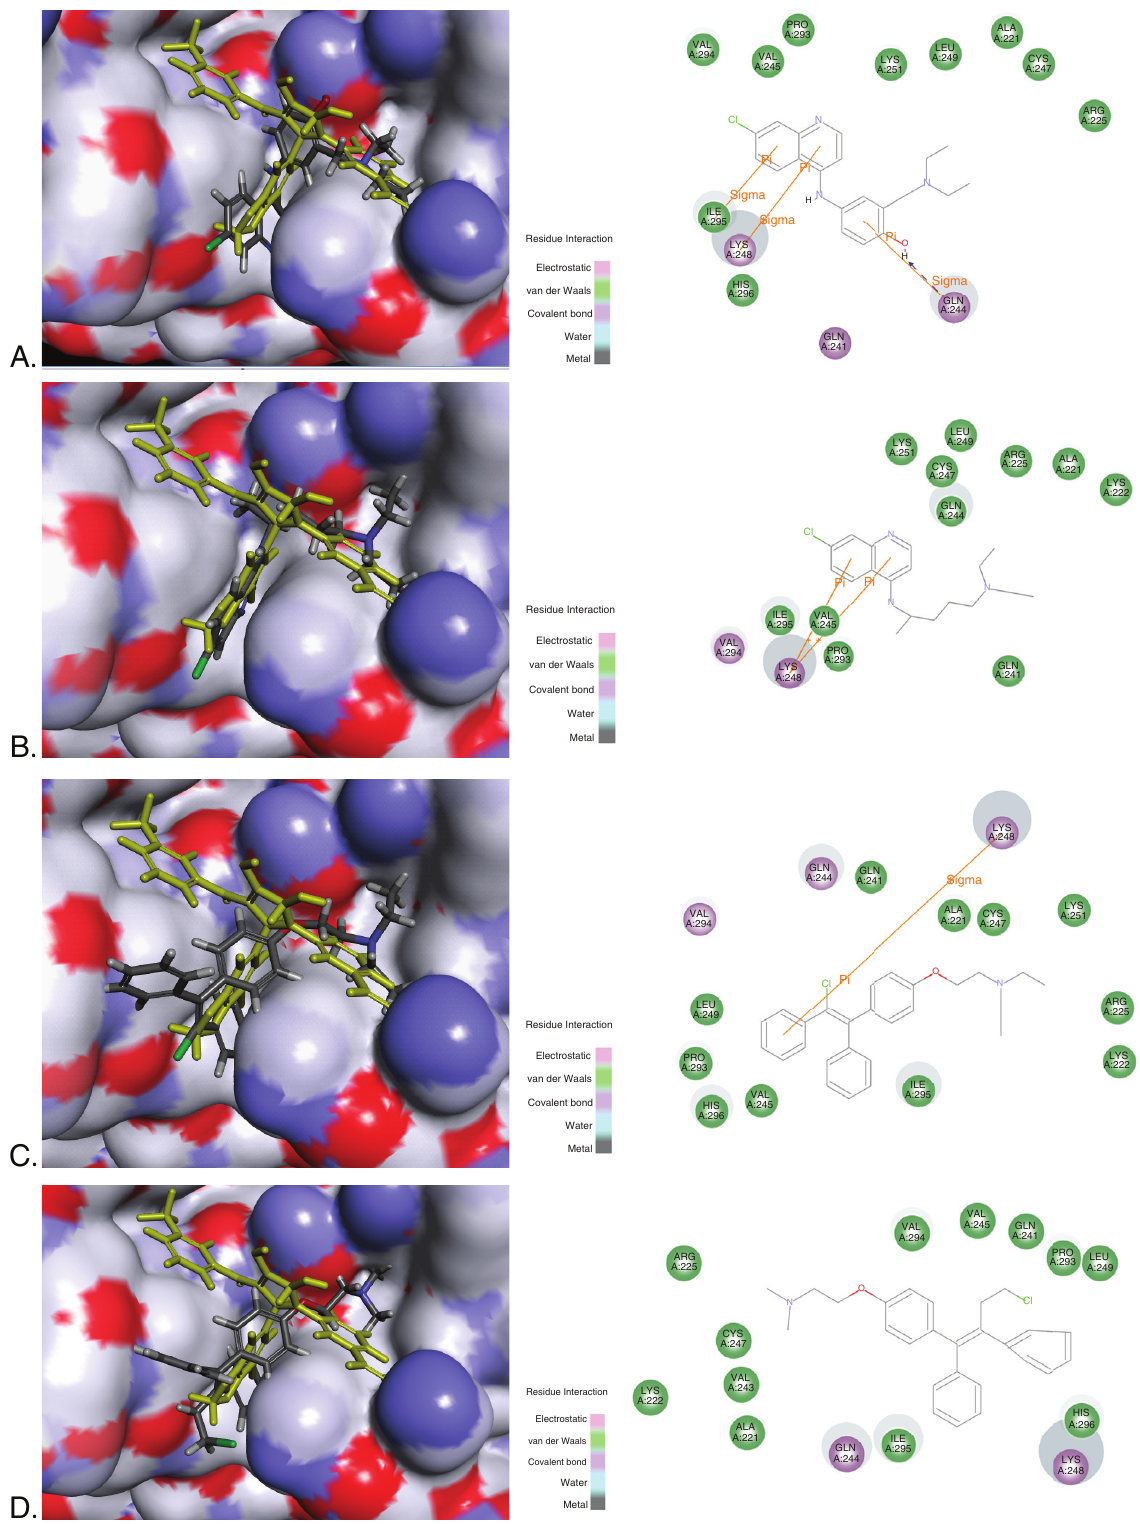
D Figure 2. Docking FDA approved compounds in VP35 protein showing overlap with ligand (yellow) and 2D interaction diagram. 4IBI was used, 4IBI ligand VPL57 shown in yellow. A . Amodiaquine (grey) and 4IBI LibDock score 90.80, B . Chloroquine (grey) LibDock score 97.82, C . Clomiphene (grey) and 4IBI LibDock score 69.77, D . Toremifene (grey) and 4IBI LibDock score 68.11